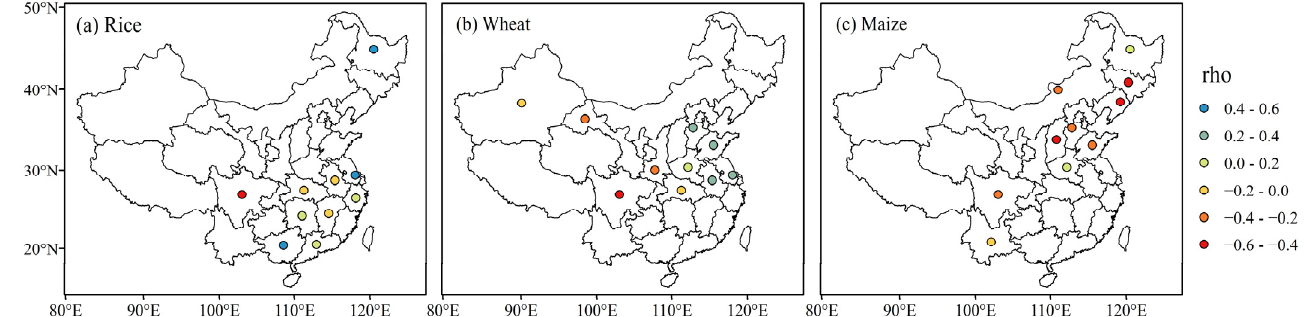
Figure 3. Spearman’s rank correlation coefficient (rho) between the detrended yield and temperature.